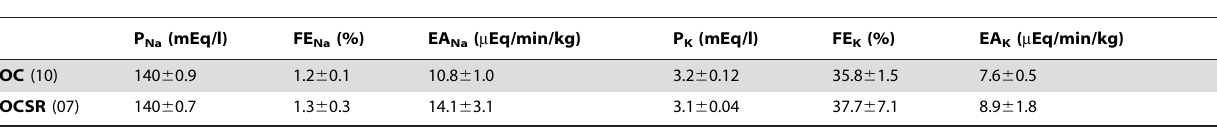
Table 2. Evaluation of sodium and potassium